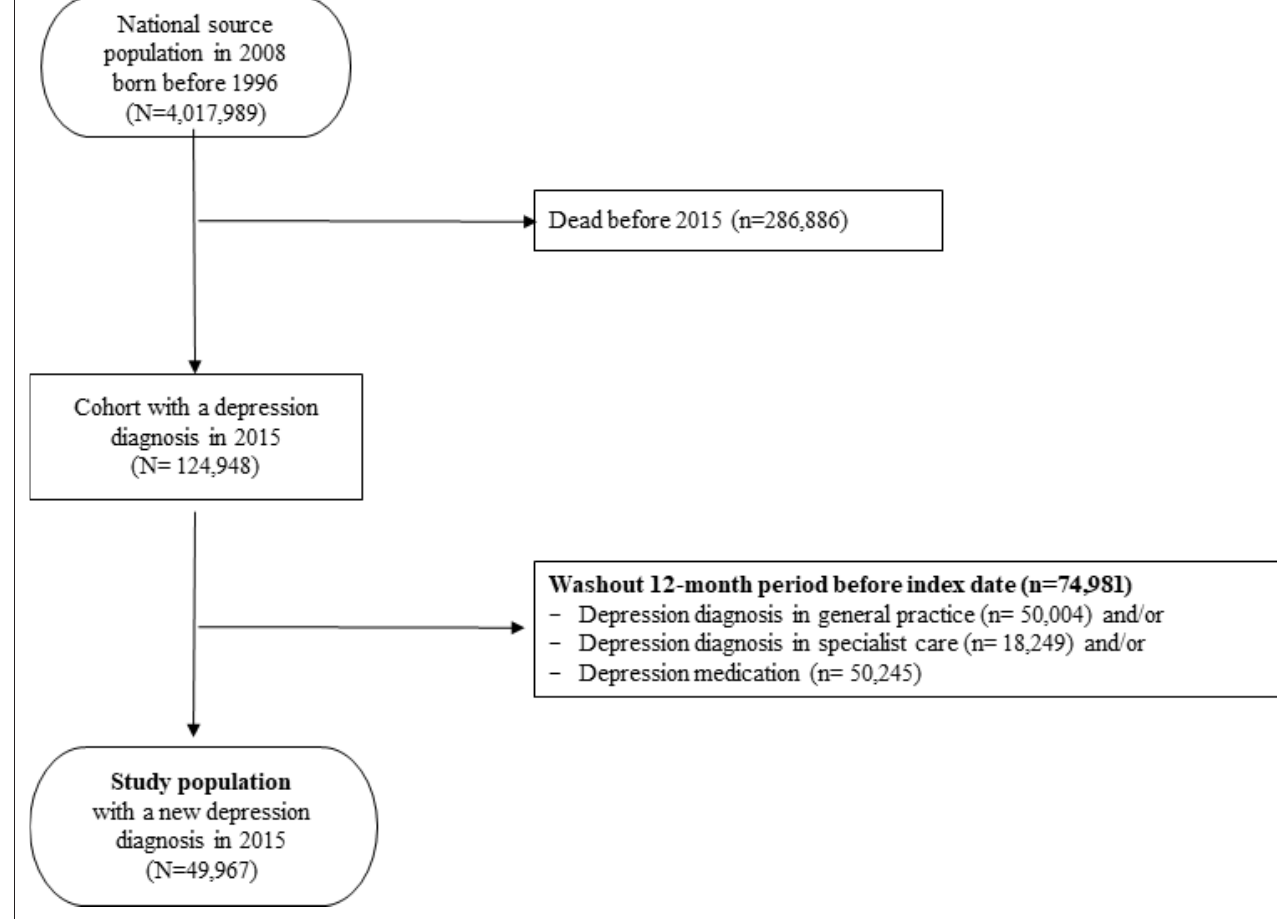
Figure 1 Flowchart illustrating the definition of the study